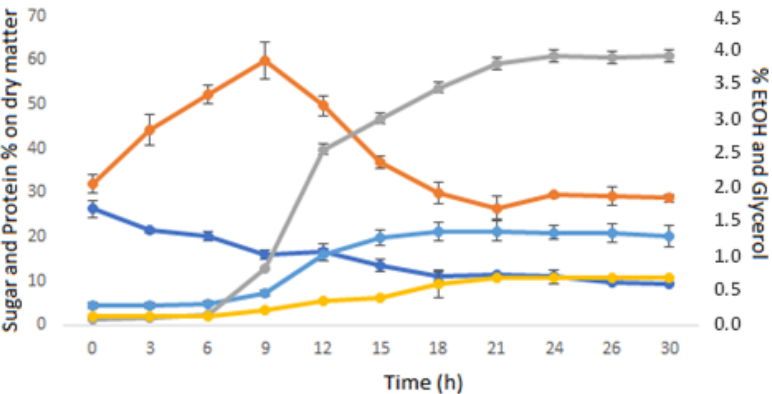
Figure 1. Trend of the main parameters evaluated during the SSF process. Light blue: % of protein, blue: % of insoluble sugars, orange: % of soluble sugars, grey: % EtOH, yellow: % of glycerol.